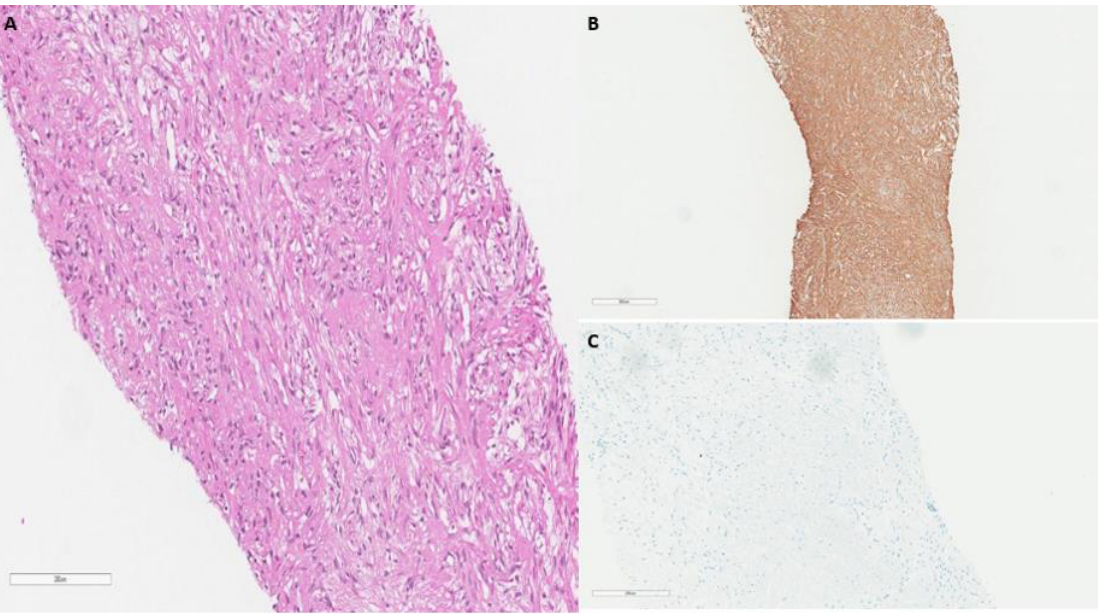
Figure 2. ( A ) H&E Pathological findings from CT guided needle biopsy show fascicular smooth muscle bundles separated by vascularized connective tissue, small round nuclei with abundant eosinophilic cytoplasm (20×). ( B ) SMA stain: strong cytoplasmic staining. ( C ) Keratin stain: negative keratin staining.